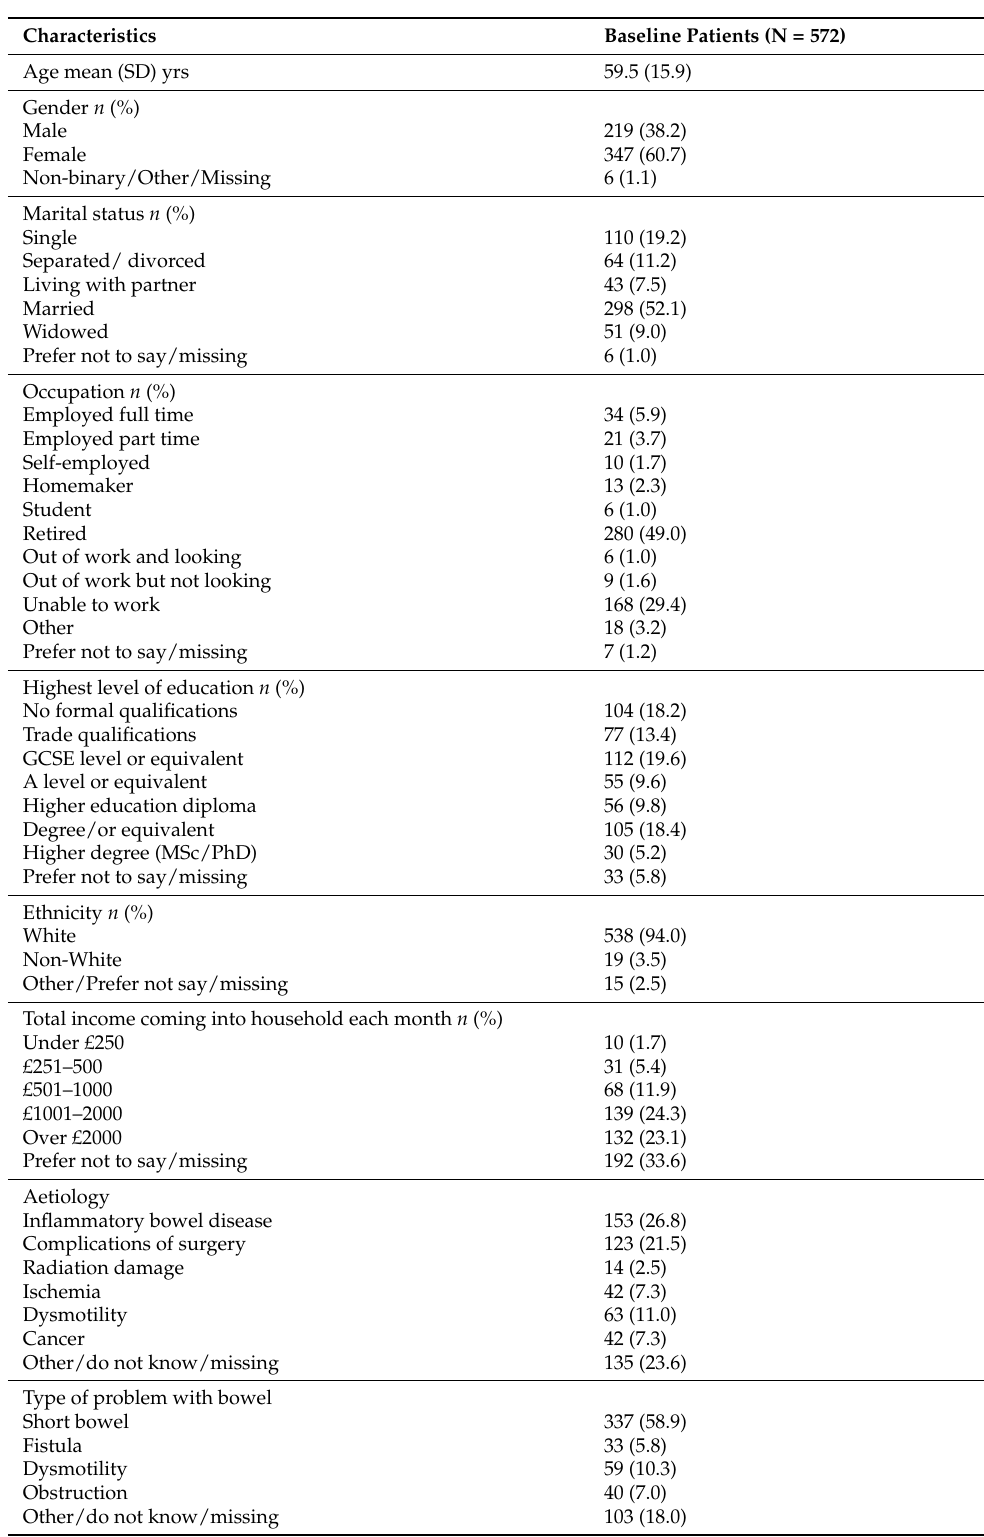
Table 1. Sociodemographic characteristics of patients receiving home parenteral support at